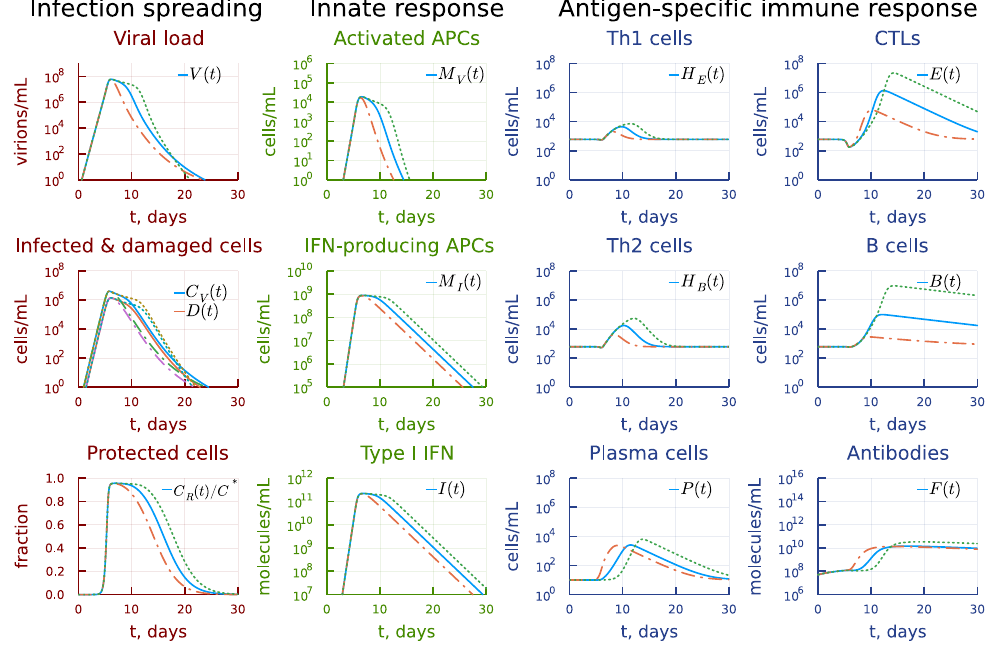
Figure 14. Effect of stronger variation of the differentiation rate constant of antigen-specific B cells into plasma cells. Dashdot: 40-fold increase of b P p , dot: 40-fold decrease of b P p relative to baseline